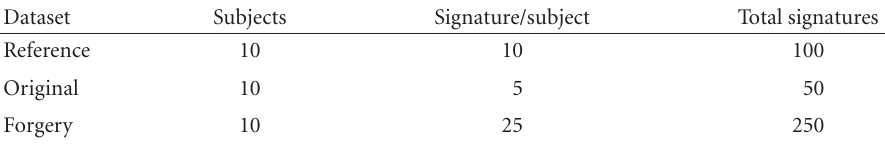
Table 2 . 1 . Signature database organization for training.